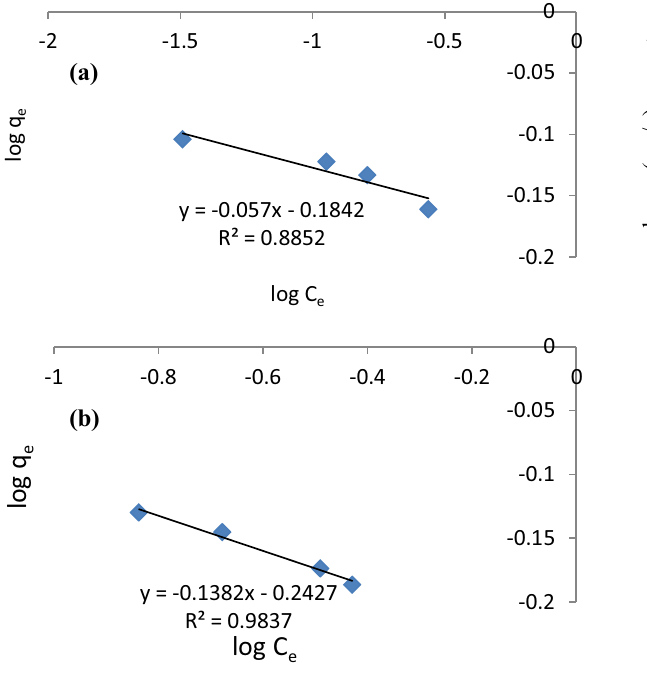
y = -0.1382x - 0.2427